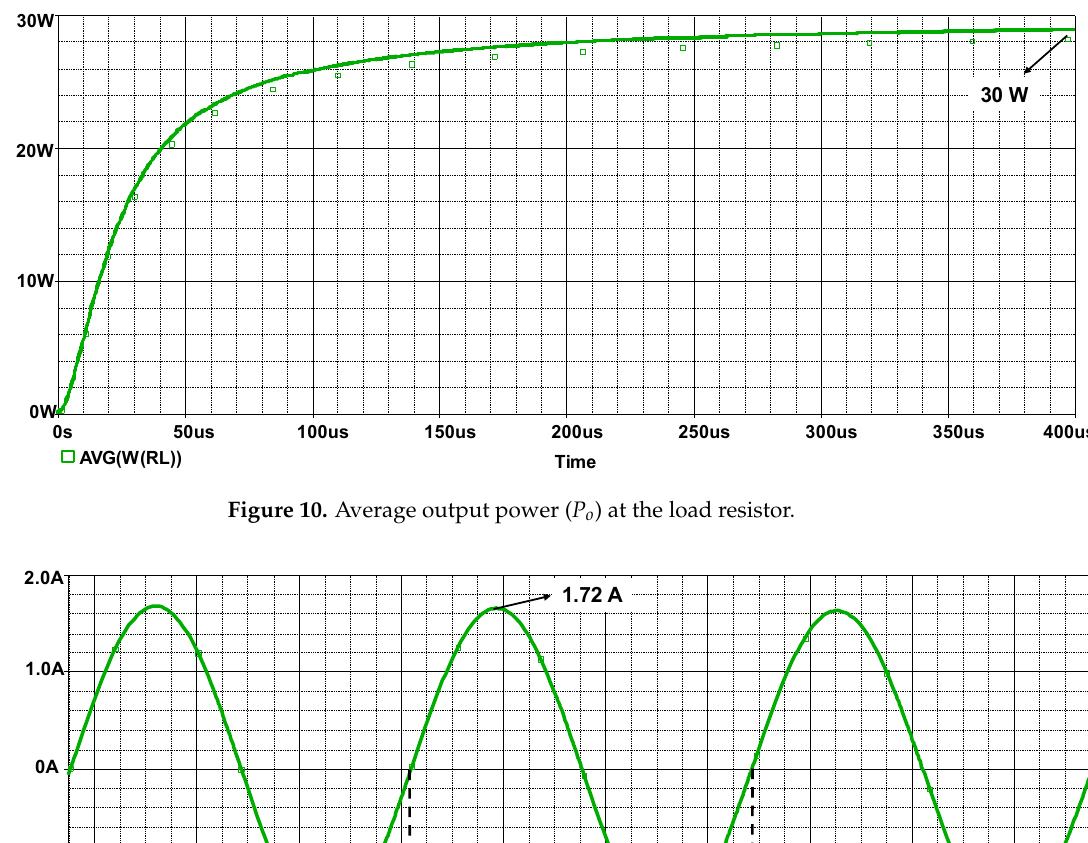
Figure 9. RMS output voltage (V out ) at the load resistor.